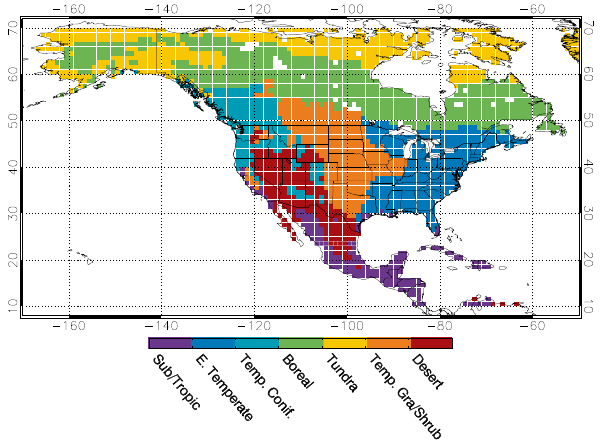
Figure 9. Biomes used, taken from Olson et al. (2001) with modifi- cations by Gourdji et al.